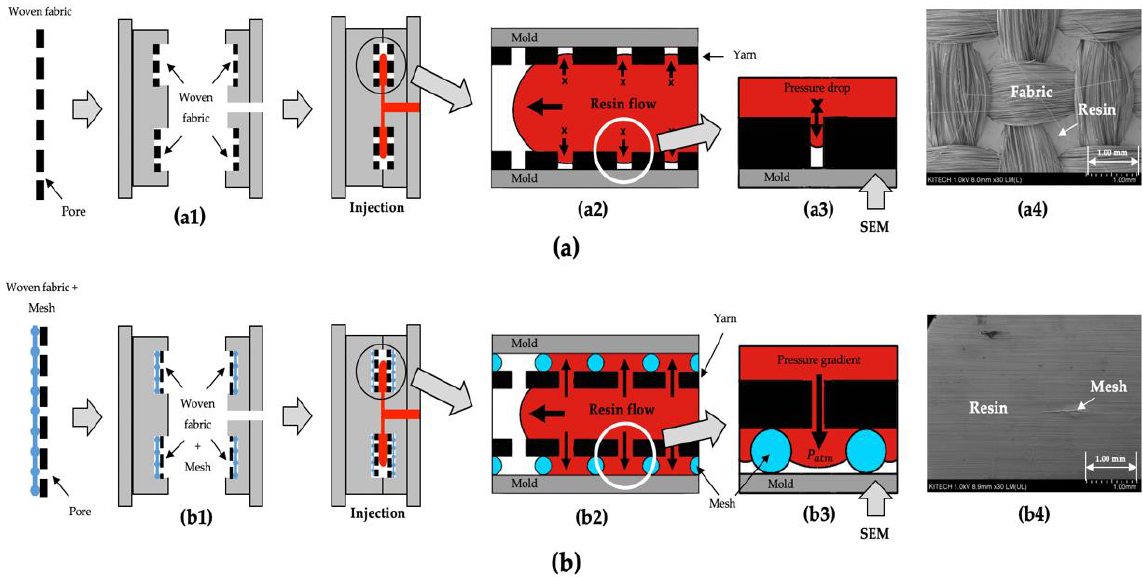
Figure 6. Schematics of the impregnation experiment and SEM images on the surface of cavity side for injection-molded composites: ( a ) placing only the woven fabrics; ( b ) placing meshes between the woven fabric and mold surface.